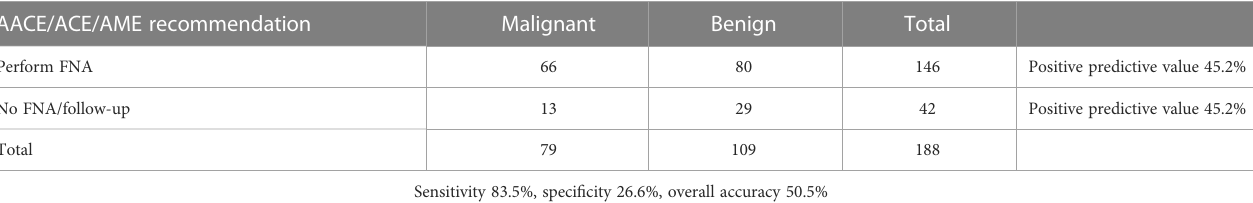
TABLE 5 Assessment of the overall AACE/ACE/AME performance. AACE/ACE/AME recommendation